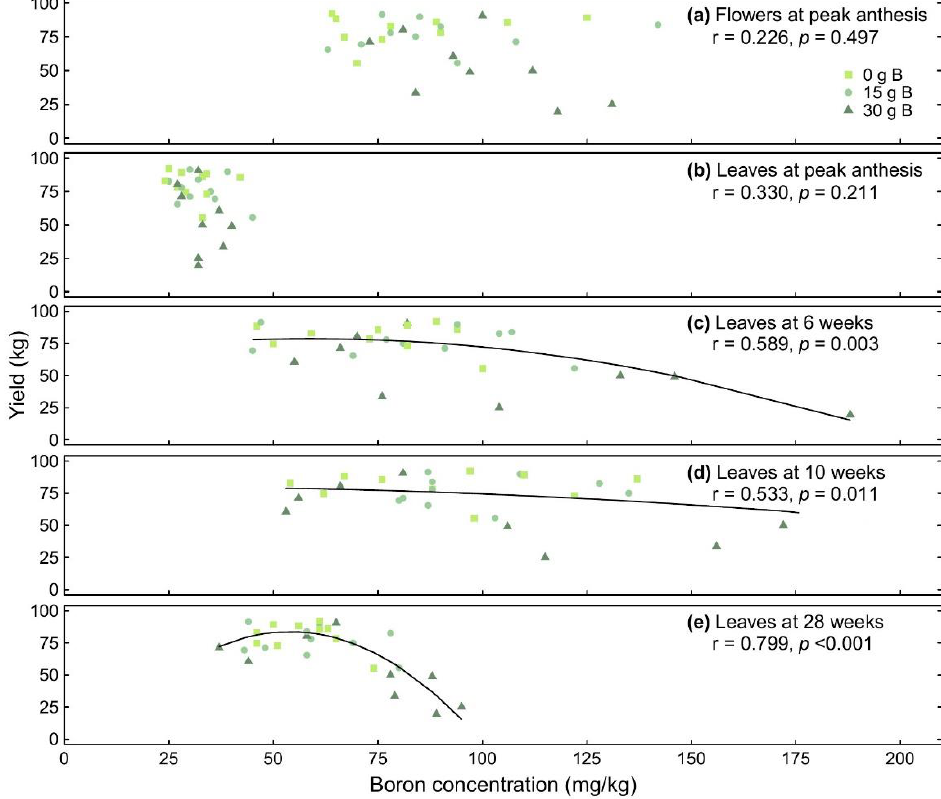
Table 1. Length, diameter, flesh mass and seed mass of mature fruit from Hass avocado trees treated with 0, 15 or 30 g boron per tree prior to peak anthesis. Fruit Parameter